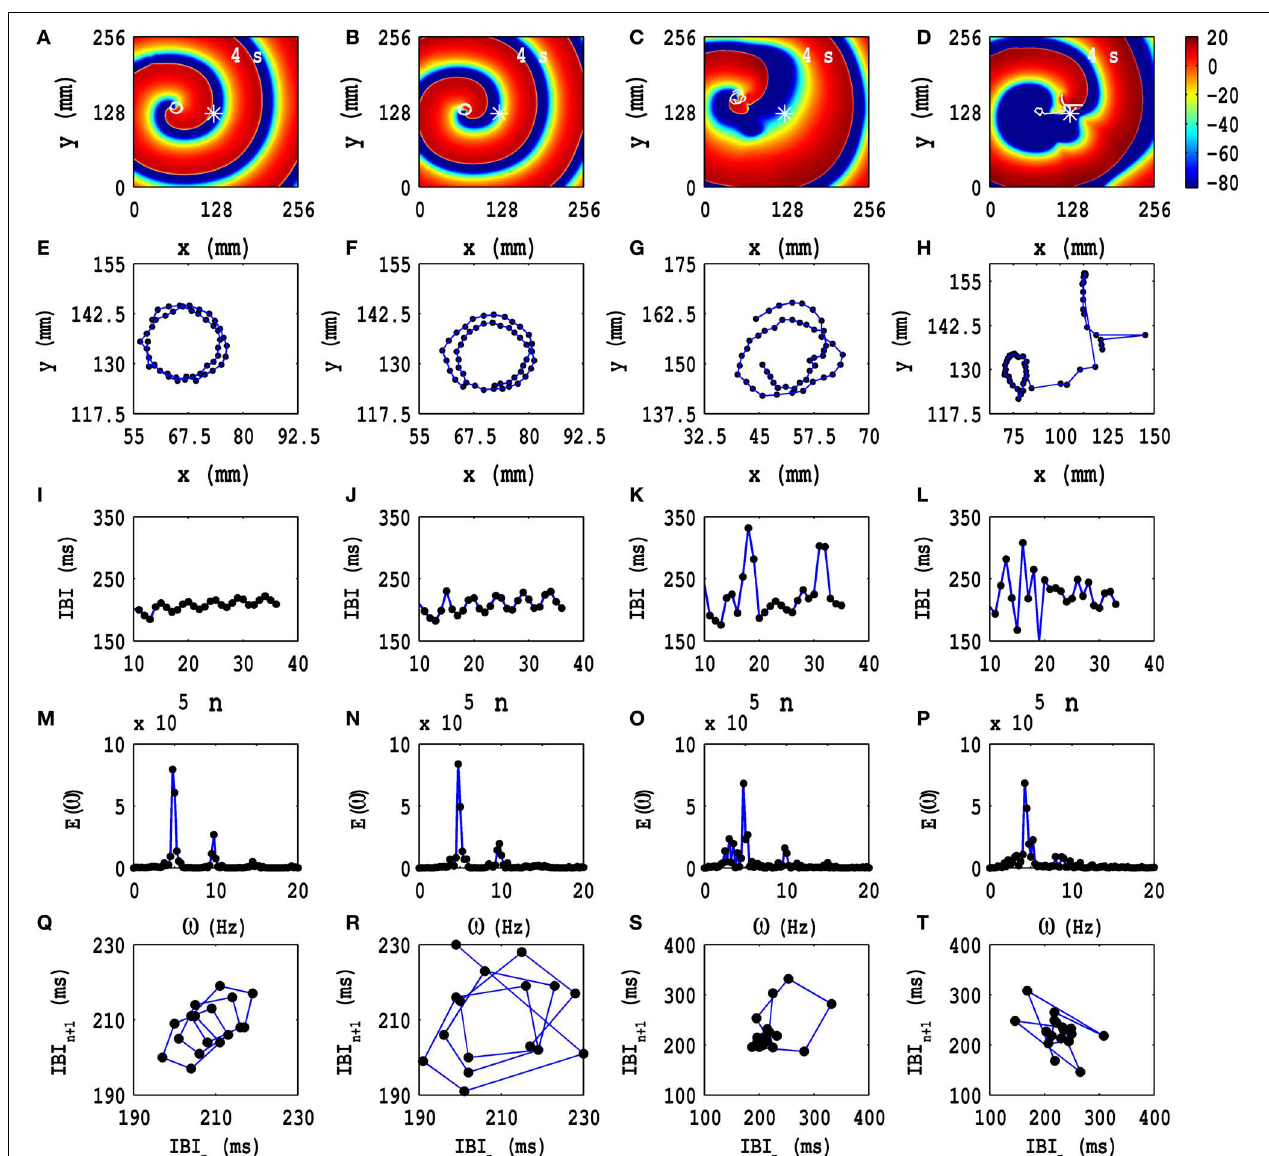
FIGURE 5 | Time evolution of the RS state in the TP06 model in the presence of PD with a fixed frequency. Pseudocolor plots of V m at time t = 4s for (A) A x = A y = 0 . 1 , f x = f y = 1 . 0Hz, (B) A x = A y = 0 . 2 , f x = f y = 1 . 0Hz, (C) A x = A y = 0 . 3 , f x = f y = 1 . 0Hz, and (D) A x = A y = 0.4 , f x = f y = 1 . 0Hz. The animations (a1–a4) in Video S3 show the spatiotemporal evolution of these spiral waves for the interval 0s ≤ t ≤ 4s. (E–H) Spiral-tip trajectories, which follow from these spatiotemporal evolutions, for 3 . 6s ≤ t ≤ 4s. We obtain the local time series of V m ( x , y , t ), from the representative point ( x = 125mm,